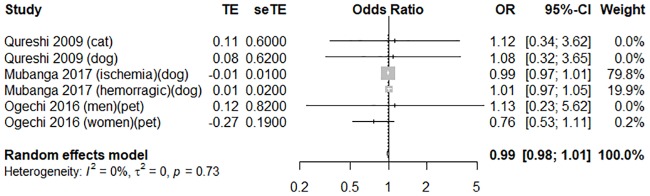
A forest plot comparing the odds ratio of stroke in pet owners and non-pet owners.CI, confidence interval; OR, odds ratio; SE, standard error; TE, treatment effect.